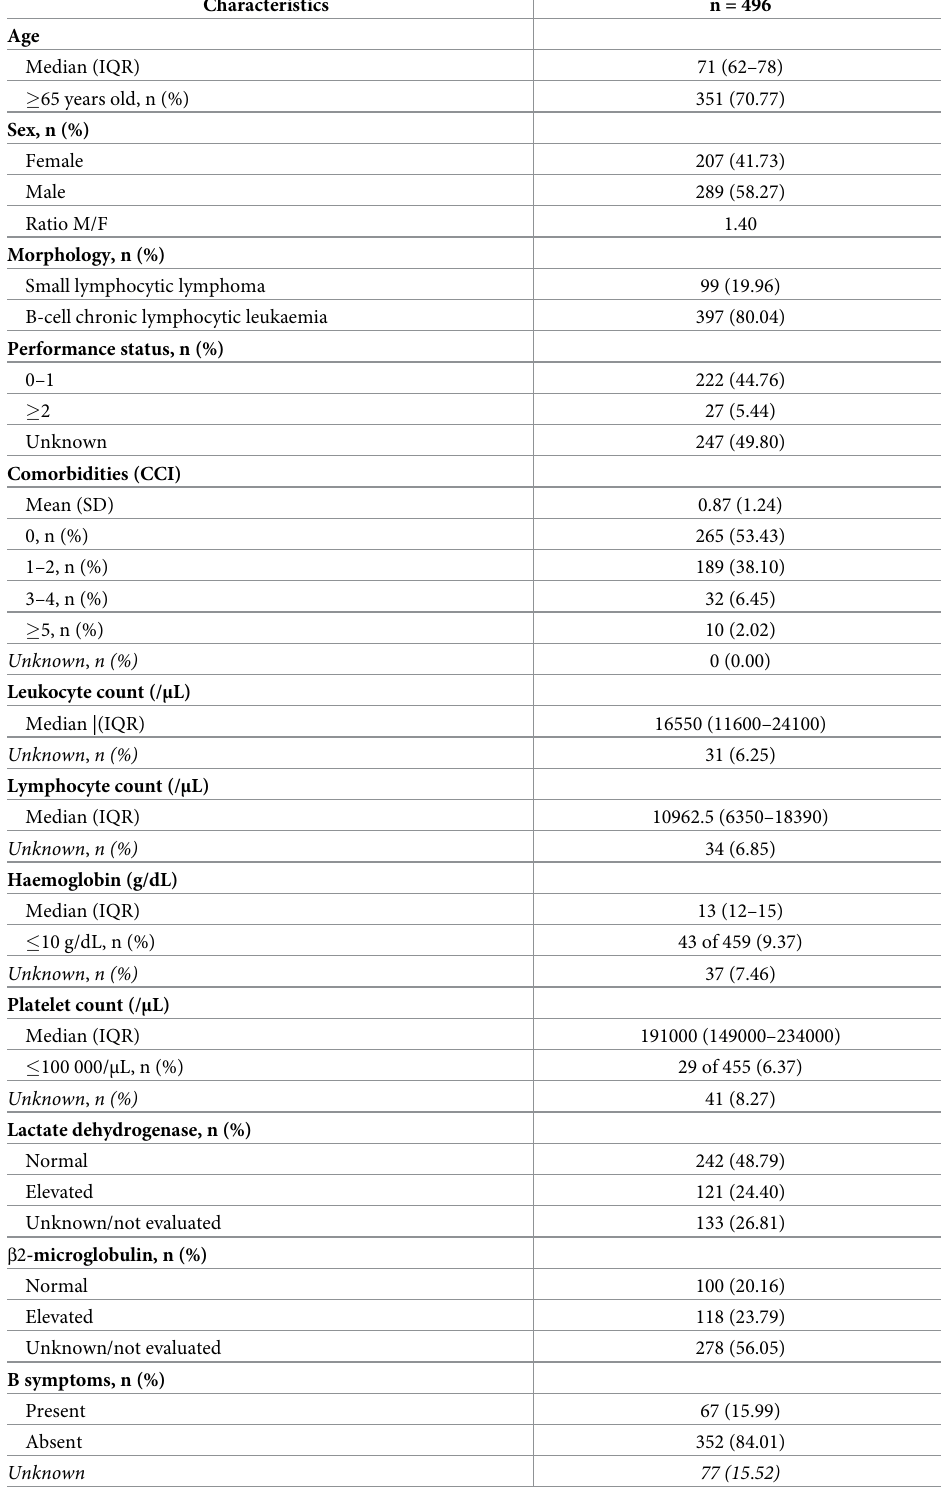
Table 1. Baseline characteristics of CLL patients diagnosed in 2013–2014 in ROR-Sul coverage